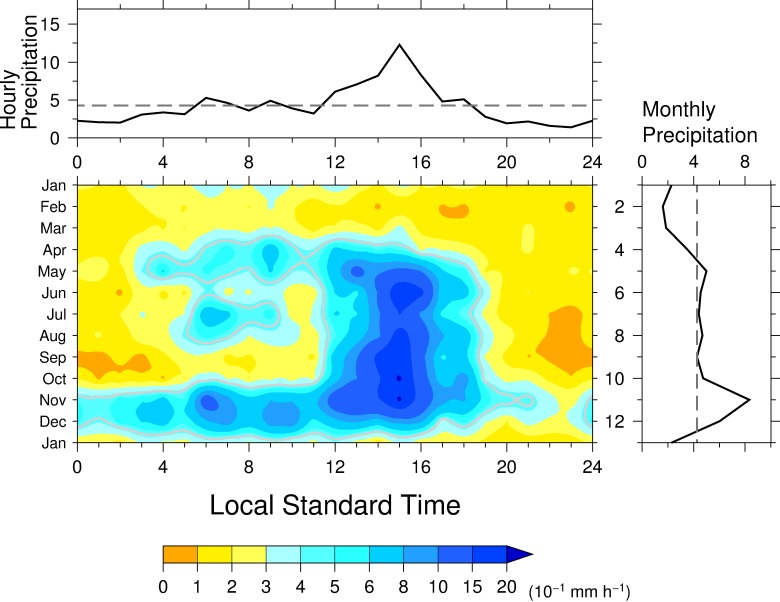
Same as in Fig 2 but for Chamon.